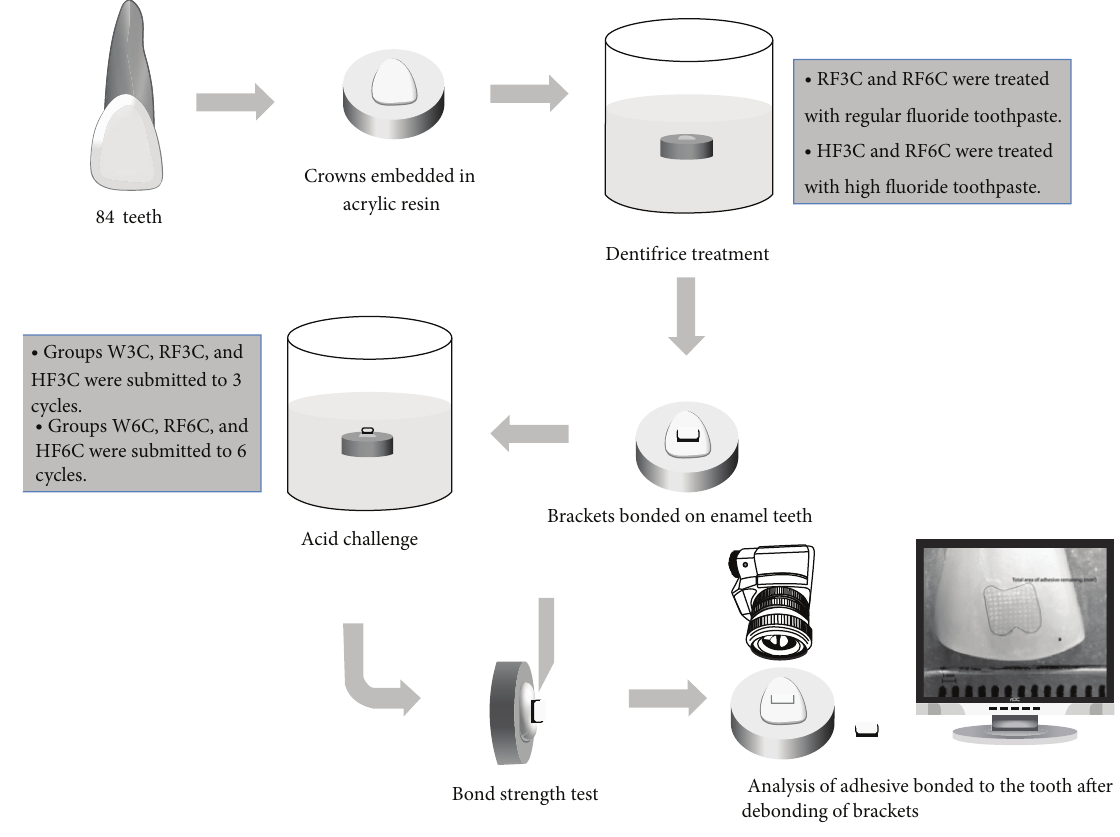
Figure 2: Schematic drawing of the methodology used in this study.